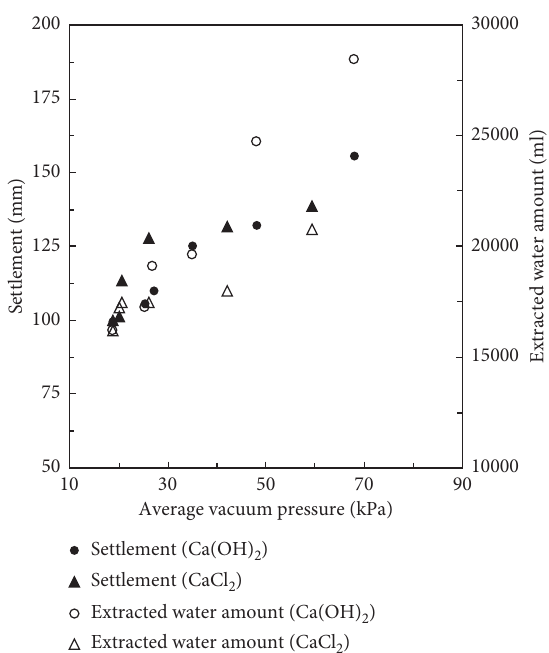
Figure 9: Variation of average vacuum pressure with settlement and extracted water